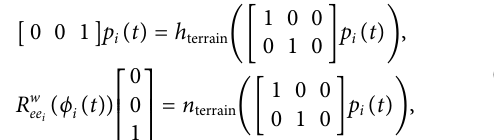
Frontiers in Robotics and AI |